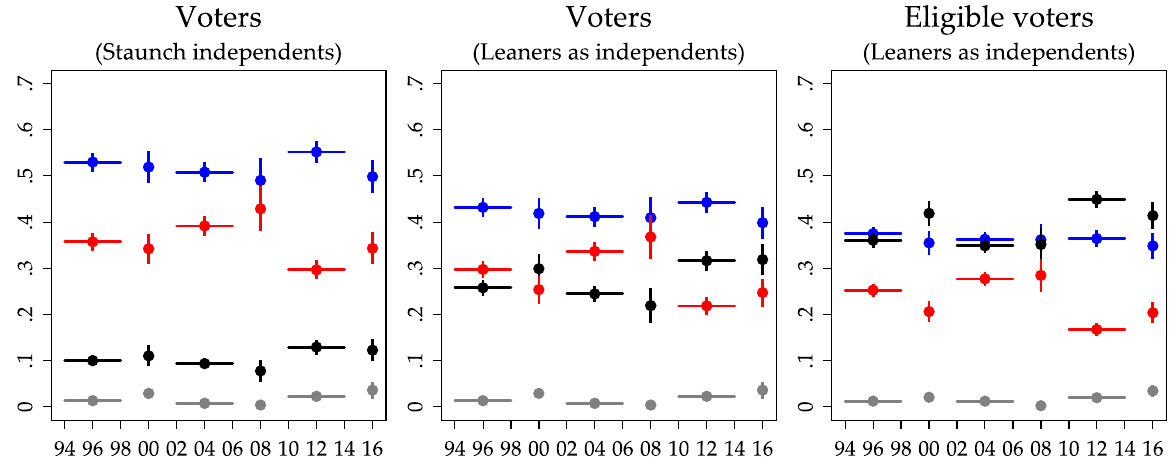
Figure 2: Class IIIb trends in identification with the Democratic Party (blue), Republican Party (red), another party (gray), and independent